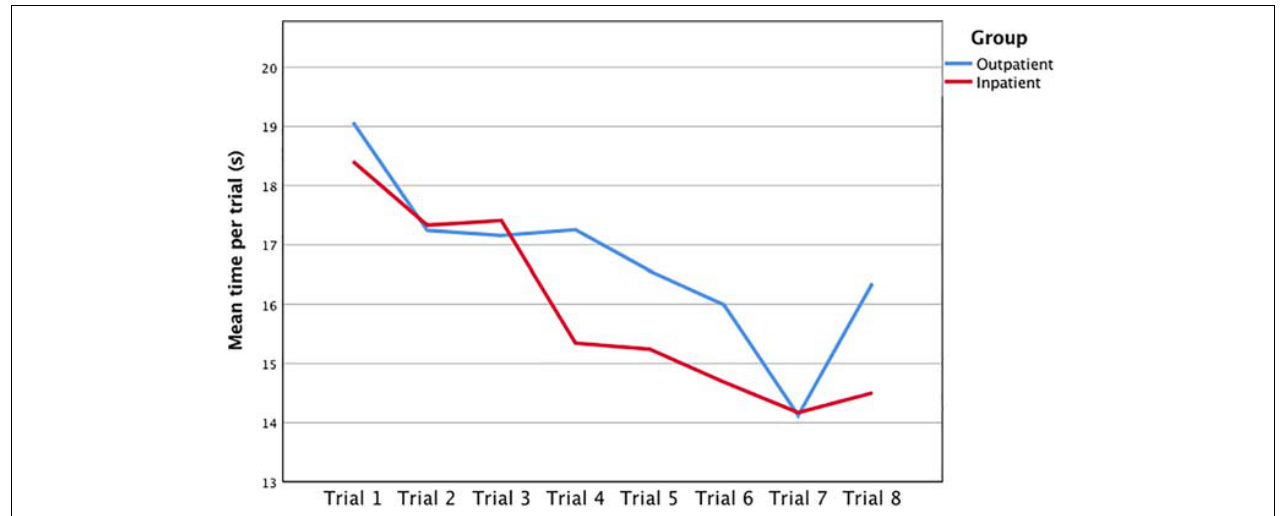
FIGURE 1 | Mean time per trial (1–8) of the computerized symbol digit modalities test (c-SDMT) by